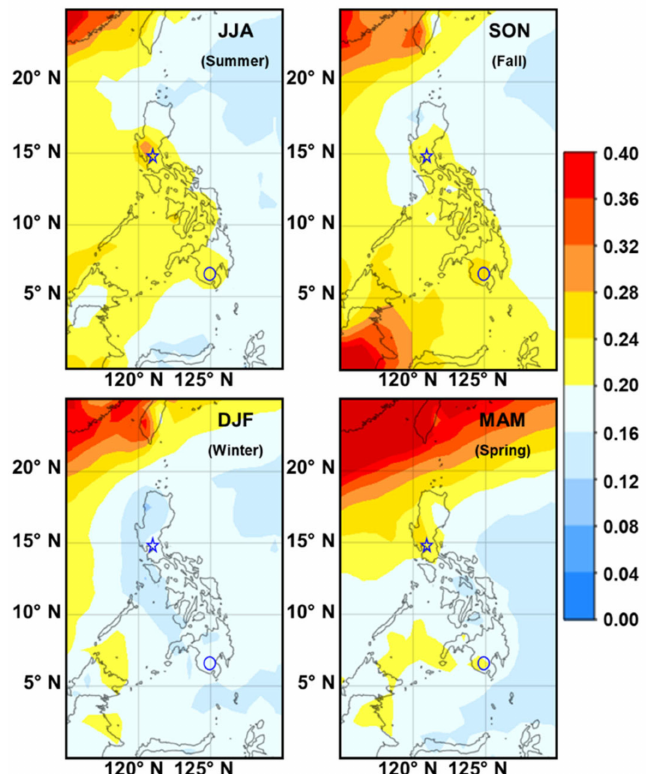
Figure 7. Spatial distribution of mean seasonal MODIS AOD values from 2010 to 2020 in the Philippines. Note that “ (cid:73) ” corresponds to Quezon City and “